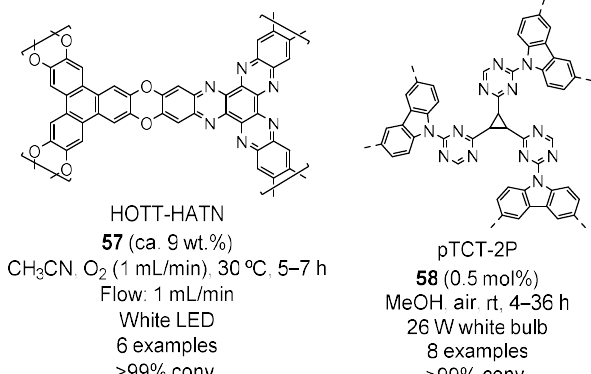
Figure 13. Results obtained in the aerobic photo-oxidative coupling of benzylamines to N -benzylidene benzylamines 2 catalyzed by 57 and 58 .